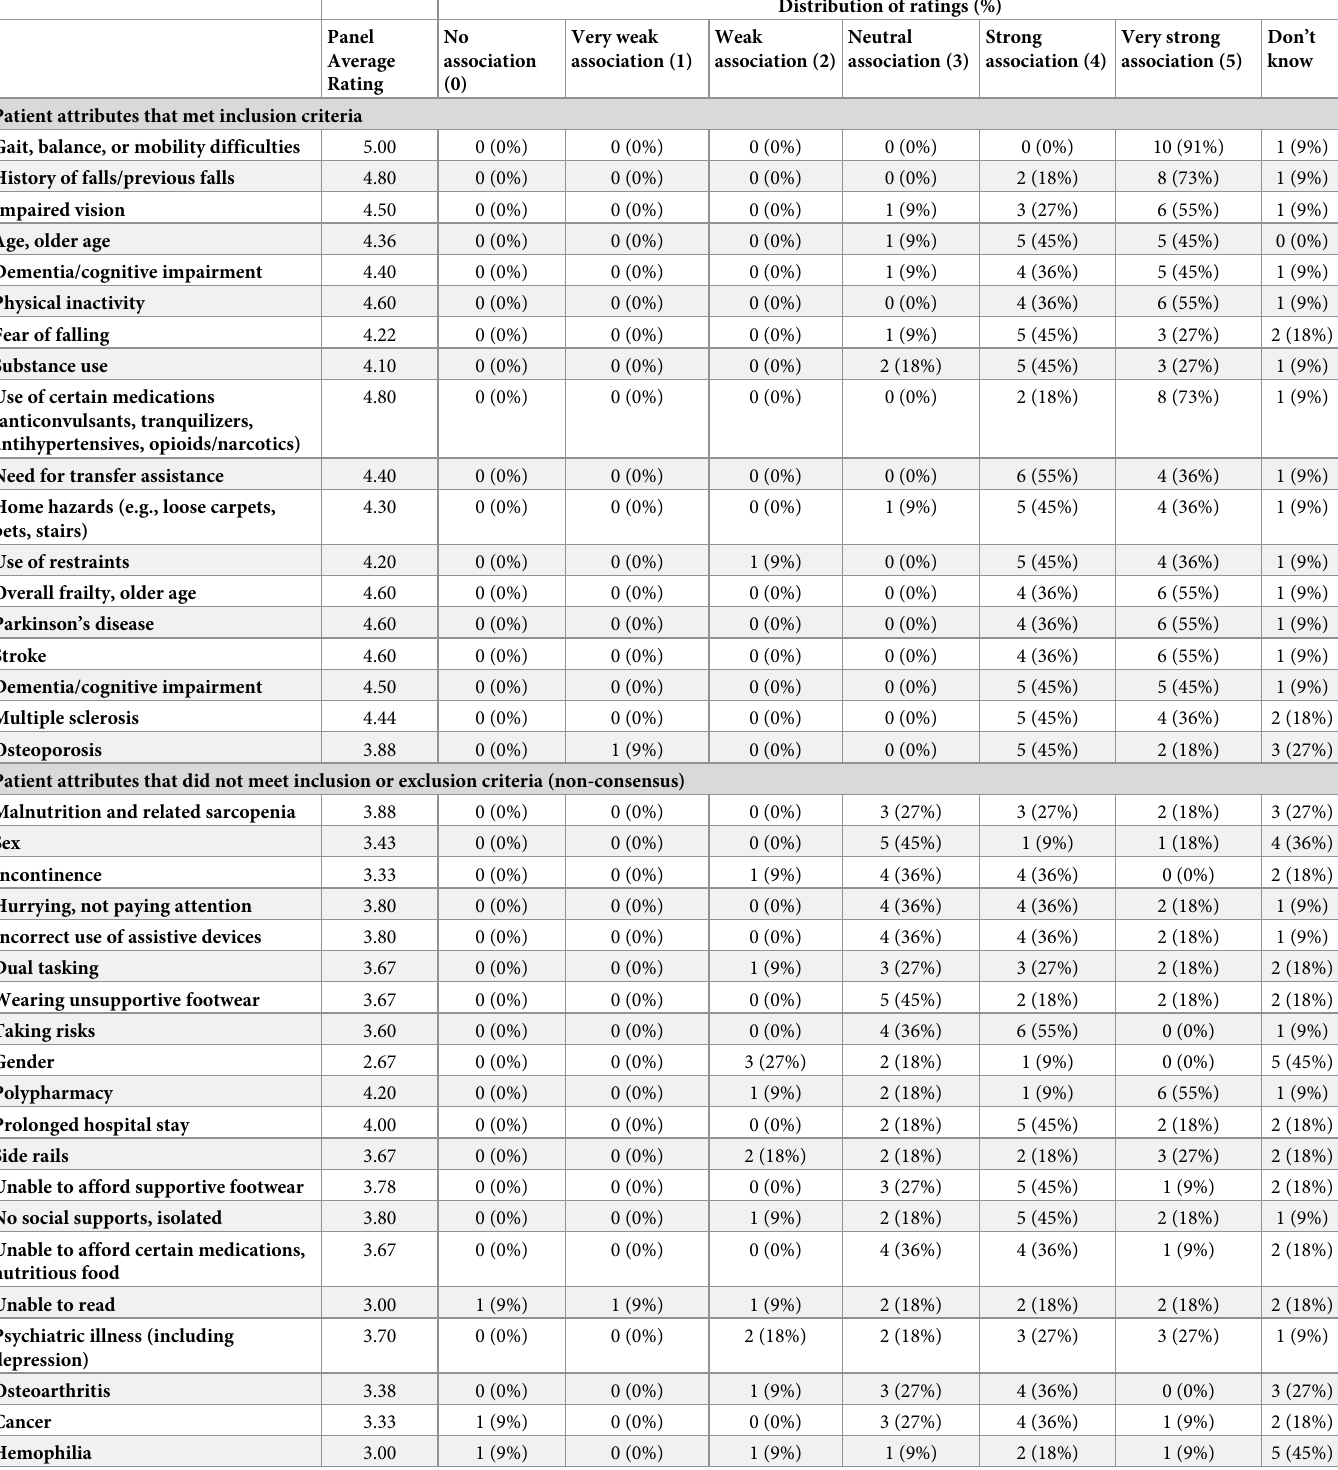
Table 3. Summary of patient attributes ratings from the first Delphi